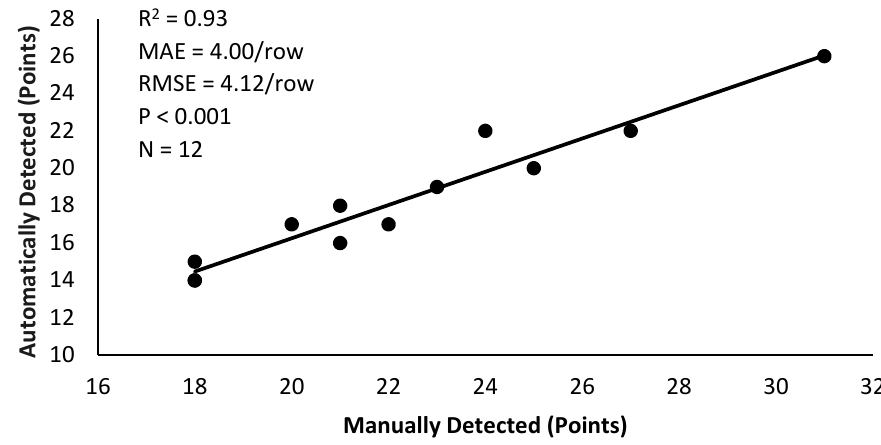
Figure 9. Correlation between manually and automatically detected points for field site I.